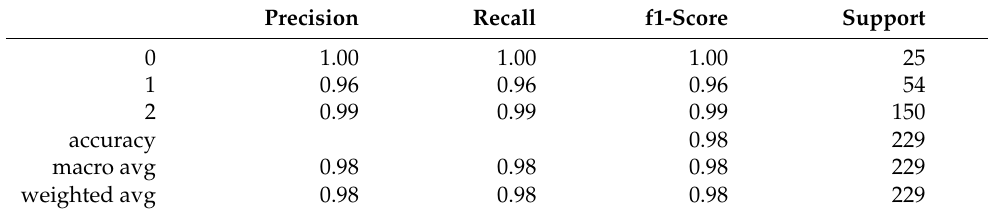
Figure 9. Gradient boosting tree confusion matrix on test-set. Table 9. ANN metrics on